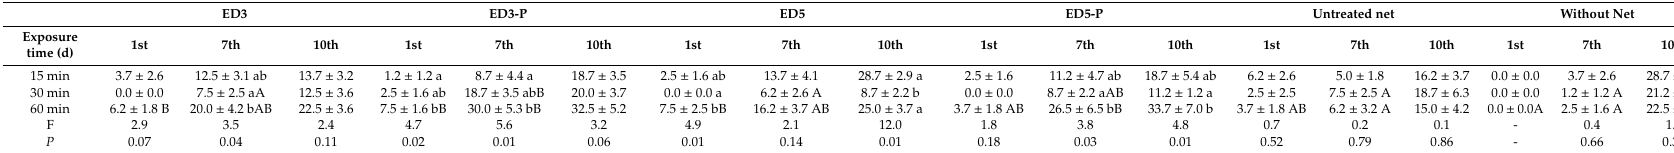
Within each exposure interval, post-exposure interval, and net formulation mortality, means followed by the same lowercase letter do not di ff er significantly according to the Tukey-Kramer HSD test at P < 0.05. Within each exposure interval, post-exposure interval, and net formulation, mortality means followed by the same uppercase letter do not di ff er significantly across treatments according to the Tukey-Kramer HSD test at P < 0.05. Where no letters exist, no significant di ff erences were noted. ANOVA parameters for 1st day were: at 15 min, F = 1.3, P = 0.6, 30 min, F = 1.1, P = 0.36, 60 min, F = 2.6, P = 0.03, for 7th day were: at 15 min, F = 1.2, P = 0.30, 30 min, F = 5.1, P < 0.01, 60 min, F = 6.1, P < 0.01, whereas for 10th day were: at 15 min, F = 2.4, P = 0.05, 30 min, F = 1.9, P = 0.12, 60min, F = 2.2, P = 0.07, in all cases df = 5, 47. In the case where “-” is indicated, F and P values were not provided in the Table since no variances among the samples were